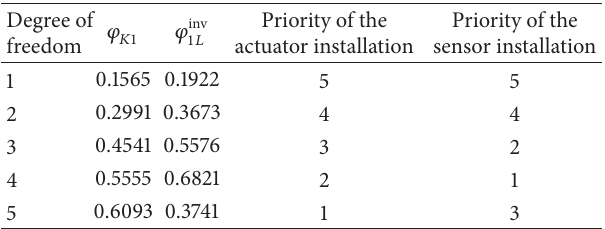
Figure 4: Five-story shear building. Table 3: The actuator and sensor locations for the five-story shear building.